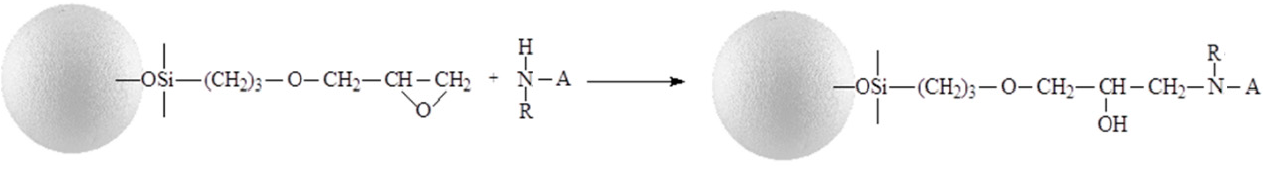
Figure 3. ESCA spectra of eremomycin ( A ) and corresponding stationary phase E-CSP ( B ). A relatively long reaction time was applied at the final stage of CSP synthesis accord- ing to the strong requirement for carrying out the reaction under mild conditions to ensure the natural configuration of antibiotics is attached to the epoxy-activated silica surface. For this reason, the reaction occurred at room temperature for 4 days. The obtained values of surface concentrations of antibiotics of 0.18–0.22 groups per nm 2 are close to the maxi- mum possible coverage of the silica surface considering the size of antibiotic molecules [43]. Therefore the selected reaction time provided good yields for the attachment of anti- biotics to epoxy-activated silica. Table 1. The elemental analysis results and corresponding concentrations of glycopeptides antibi- otics and their derivatives in the prepared CSP. Antibiotic